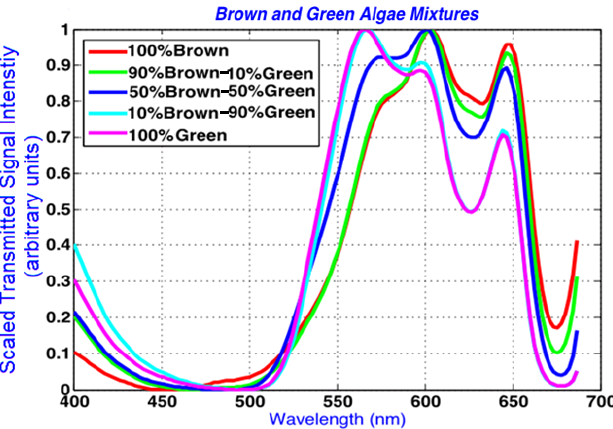
Figure 6. Scaled spectra from 100% green, 100% brown (diatom: Cyclotella sp.), and various volumetric combinations of the two. The data is scaled between 0 and 1 within 400 and 690 nm as described in Section 2.3, and demonstrates the absorption bands and peak and shoulder shifts among the algae samples more